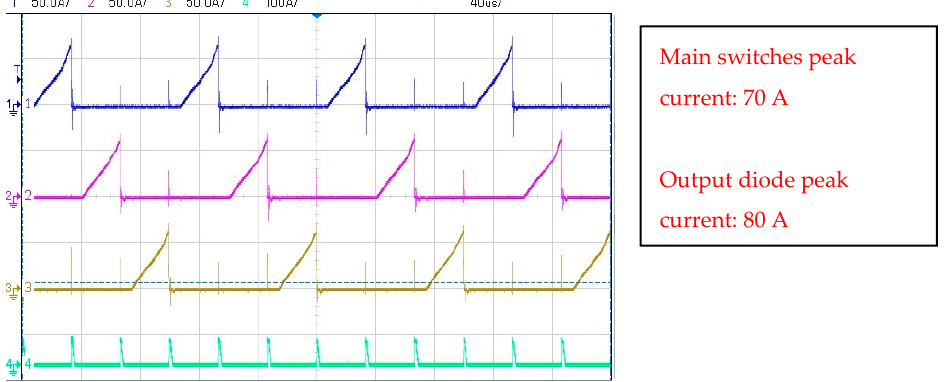
Figure 21. Experimental waveforms. Current: main switch 1 (yellow), main switch 2 (pink), and main switch 3 (yellow); scale 50 A/div. Output diode current (green); scale: 100 A/div. Base time Base time 40 µ